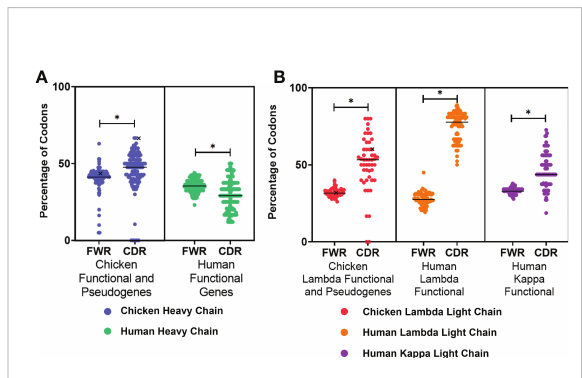
FIGURE 2 Proportion of activation-induced deaminase (AID) hotspots in the framework regions (FWR) and complementarity-determining regions (CDR), comparing (A) chicken heavy chain functional variable gene and variable pseudogenes against human functional variable genes and (B) chicken lambda light chain functional and pseudogene variable genes against human lambda functional genes as well as human kappa functional genes. Both RGY and WRC hotspots were included in the analysis (AAC, AGC, TAC, TGC, AGT, GGC, and GGT). Black “ X ” denotes the single chicken functional gene. Datasets were statistically analysed using a Mann – Whitney test. p-Values: *p ≤